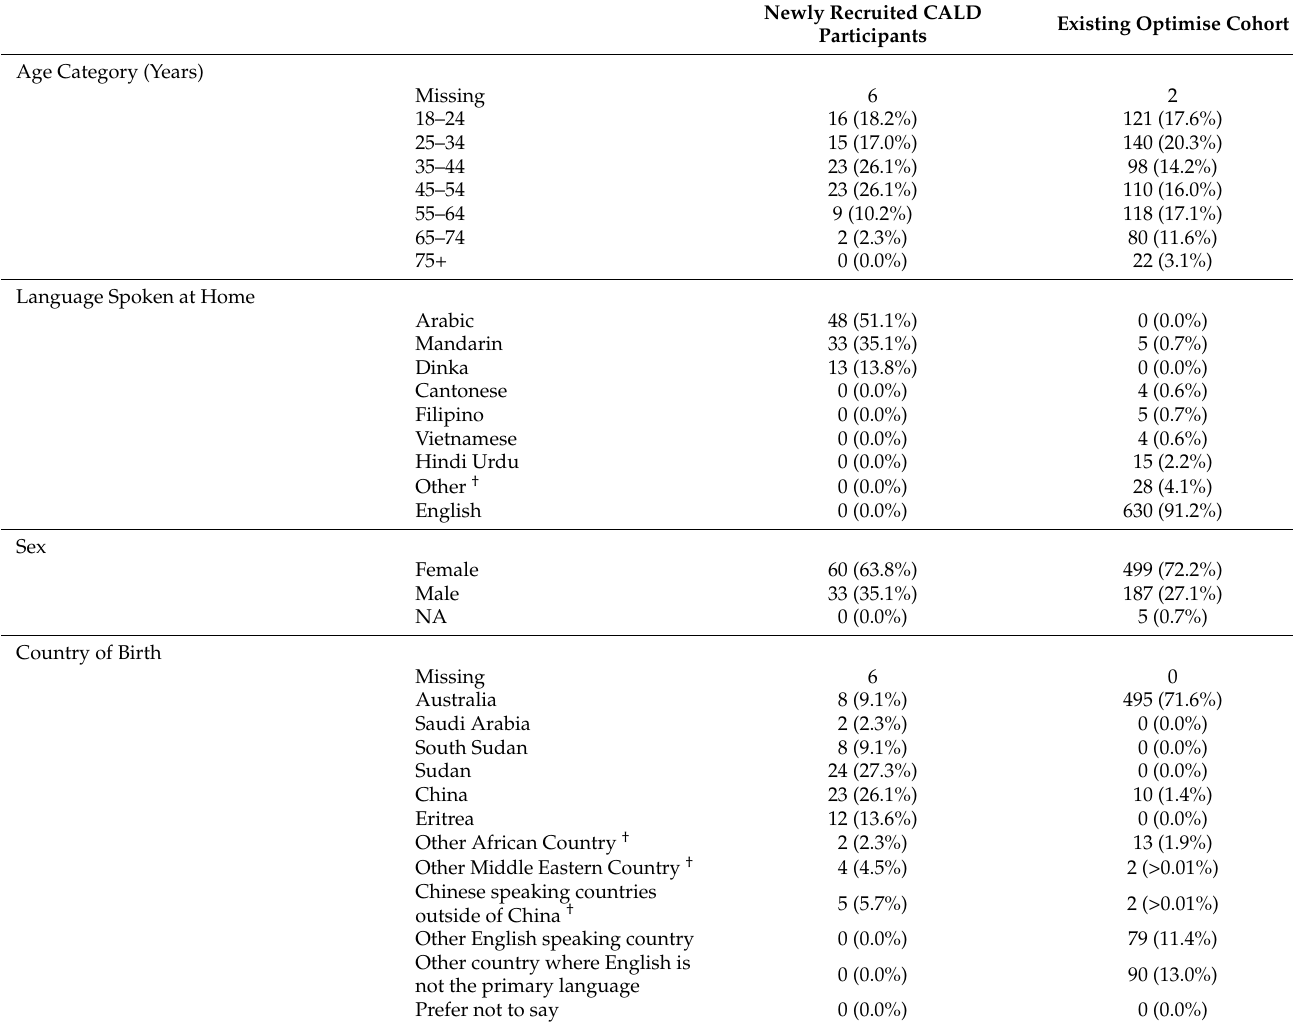
Table 1. Participant Demographics recruited by bi-lingual data collectors reported as count